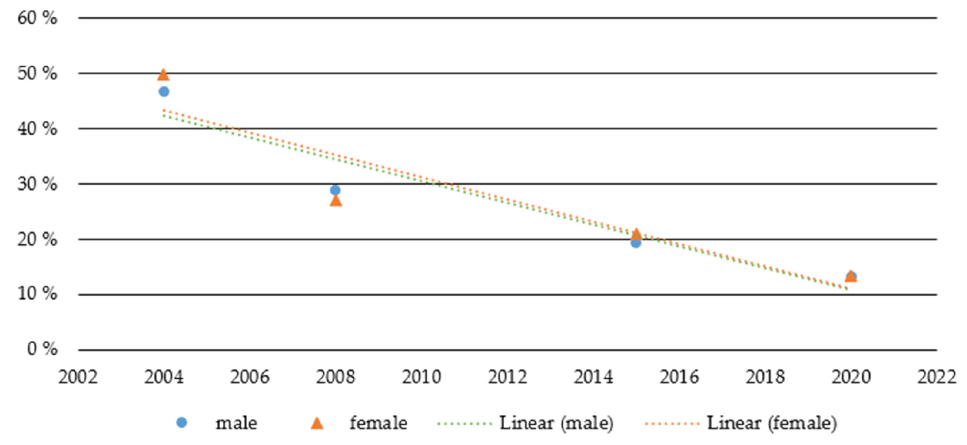
Figure 2. Daily smoking among adolescents and young adults between 2004 and 2020.